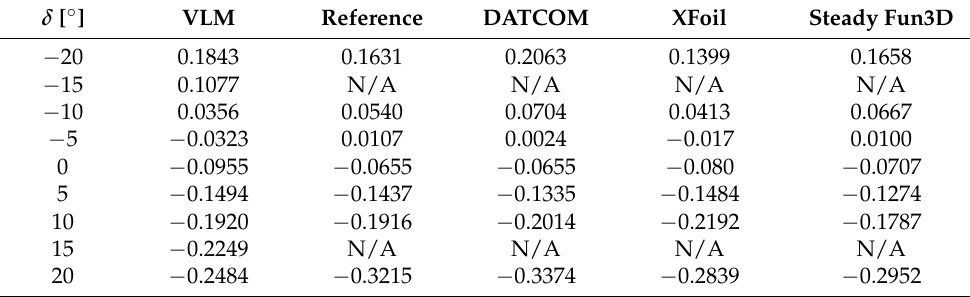
Table A7. Comparison of C h for GA(W) − 1 at alpha − 8 ◦